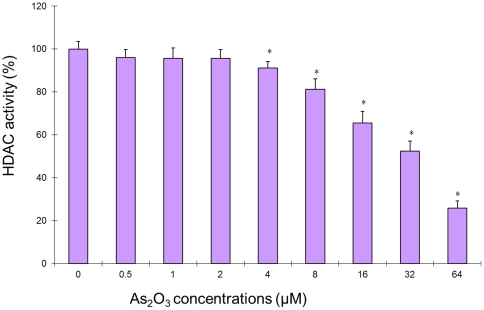
As2O3 can cause a decrease in HDAC activity.Graphs in the panel are HDAC activity expressed as ODs, in the same scale as the positive and negative controls that are also HeLa cells extracts with and without trichostatin A treatment. At the bottom are values of As2O3 treatment concentration. * means statistical difference was observed between the treated group and control (P<0.05).